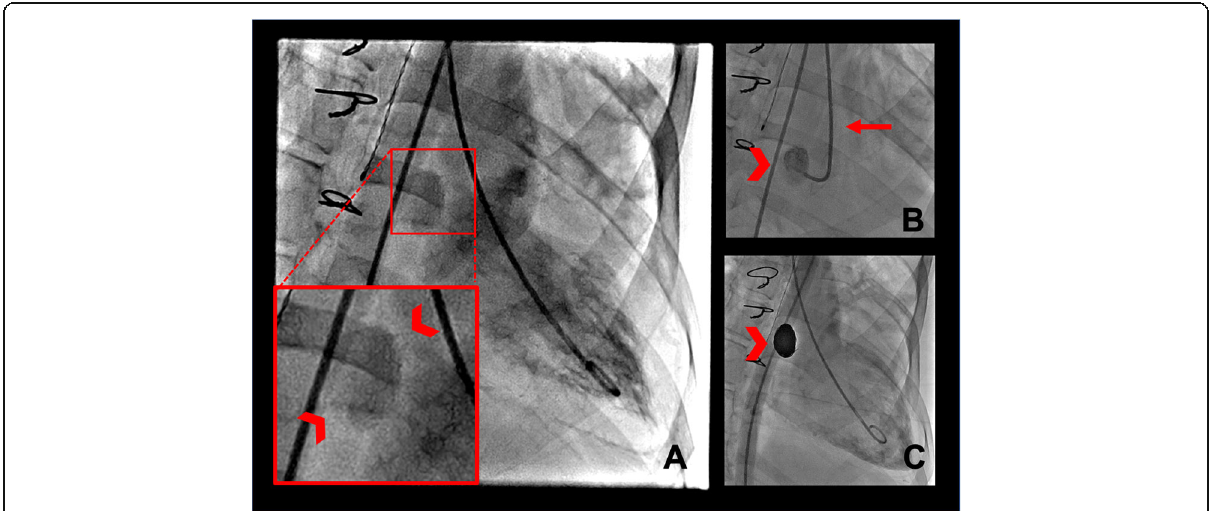
Fig. 2 a Angiographic left ventriculogram remonstrates the aortic root pseudoaneurysm (red circle). b Successful catheterization of the pseudoaneurysm sac using the 6 French IMA catheter (red arrowhead). c Follow up left ventriculogram demonstrates no appreciable filling of the pseudoaneurysm post-coiling (red